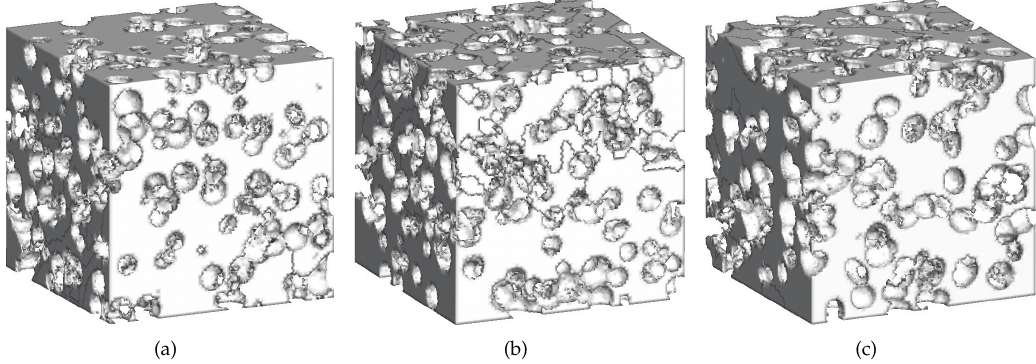
Figure 10. Numerically generated microstructures of the three porous materials with f = 0.6: ( a ) porous titanium, ( b ) porous CoCrMo alloy and ( c ) porous tantalum.